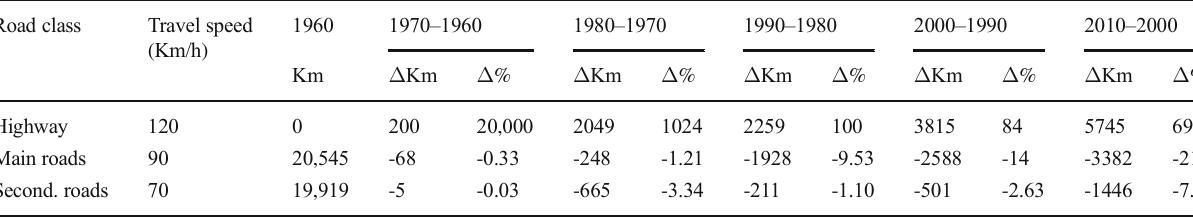
Change of road length, by road class Road